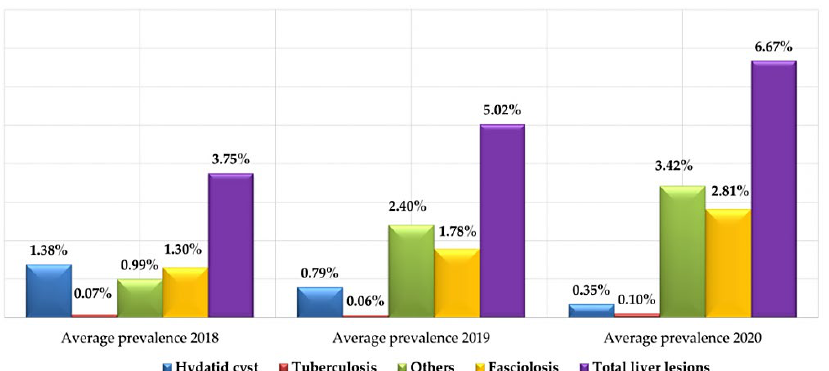
Figure 4. Liver lesions, consistent with the presence of an Echinococcus granulosus cyst complicated by a bacterial infection (presence of caseating abscesses, green arrow). row)